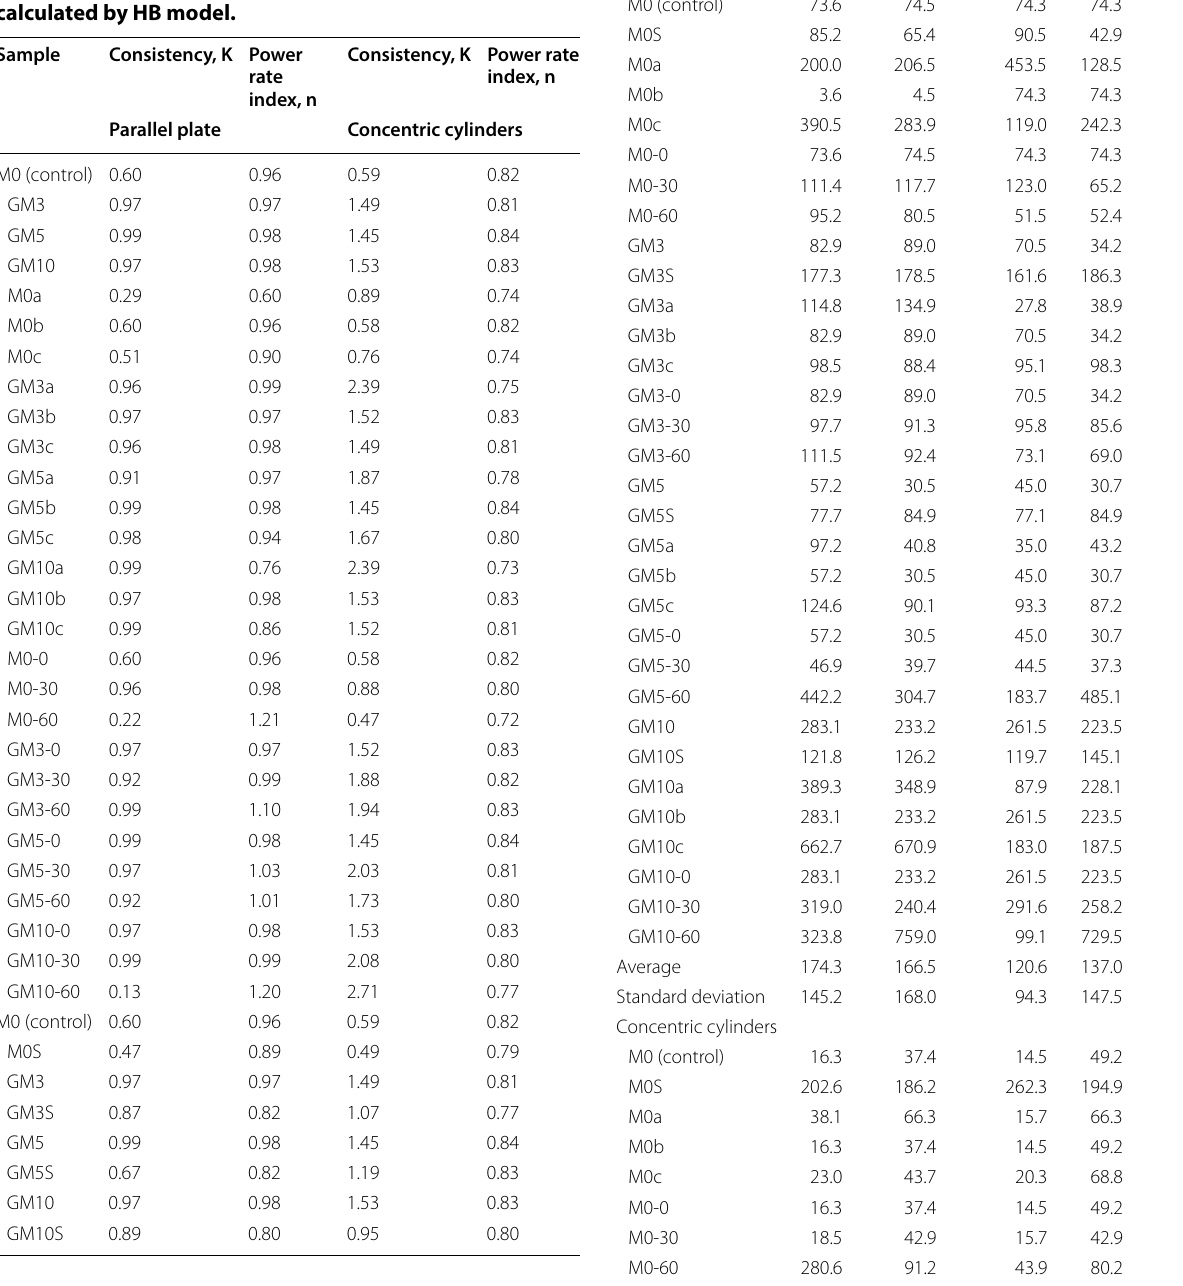
Table 15 Consistency and power rate index values calculated by HB model.